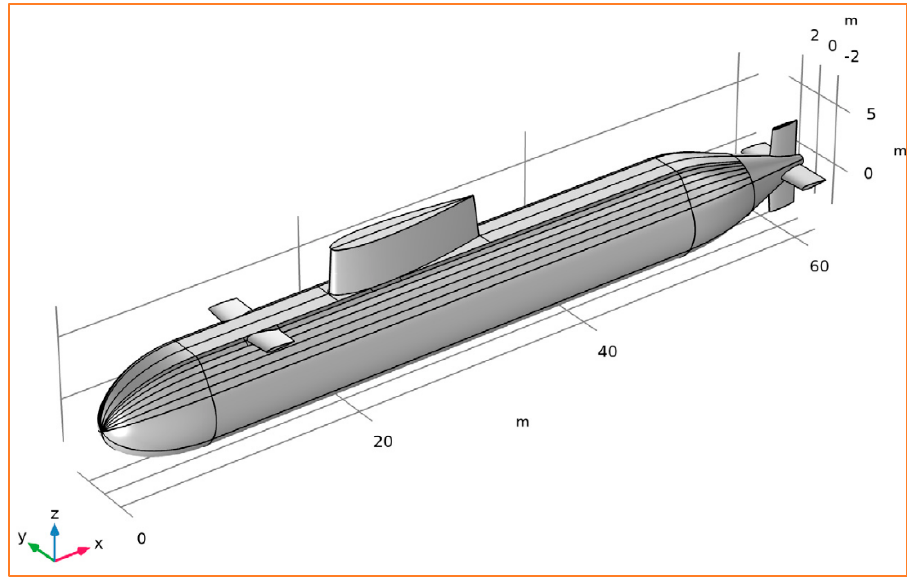
Figure 3. Submarine geometry of BeTTSi.